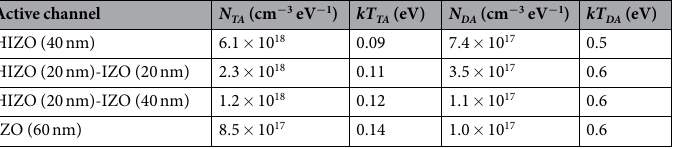
Table 1. Parameters of sub-gap density of states extracted using the discharging current analysis